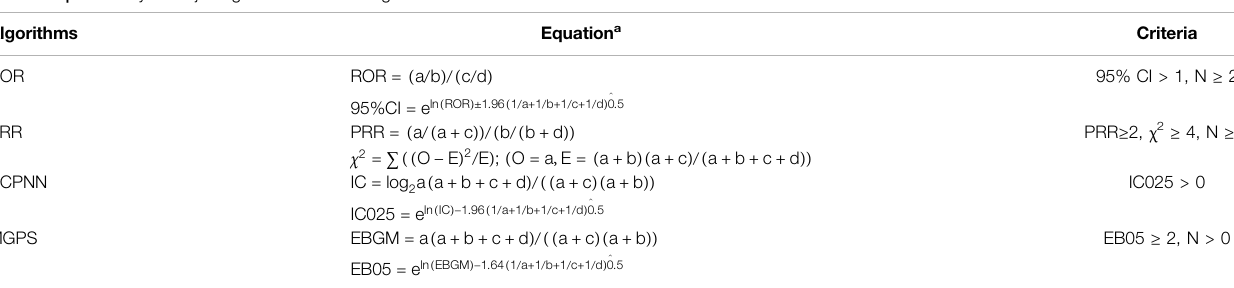
TABLE 1 | Summary of major algorithms used for signal detection.